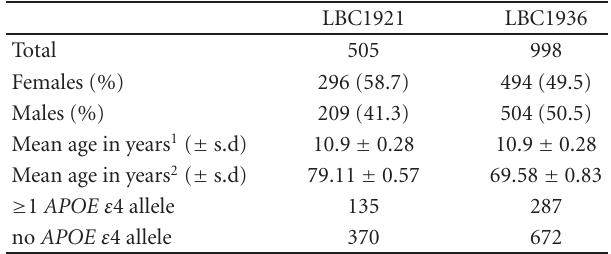
Table 1: Details of the Lothian Birth Cohorts of 1921 and